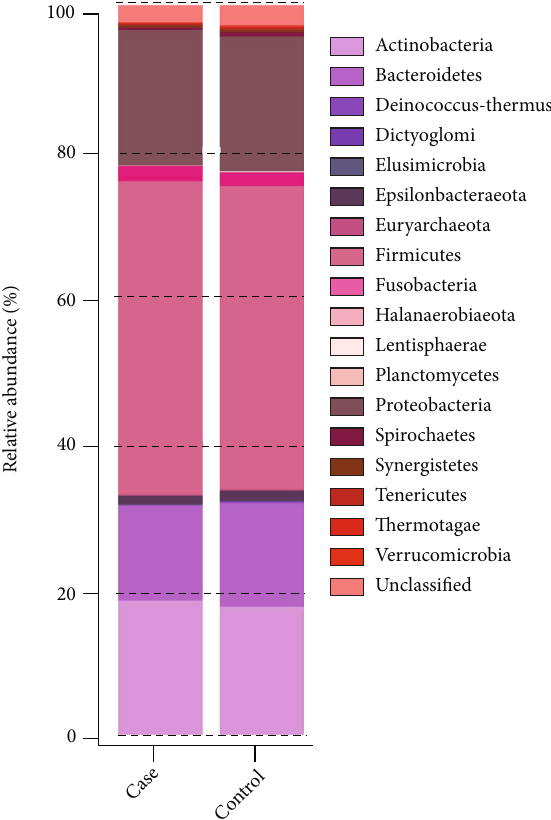
Figure 6: A column chart shows the relative abundances of species at the phylum level.